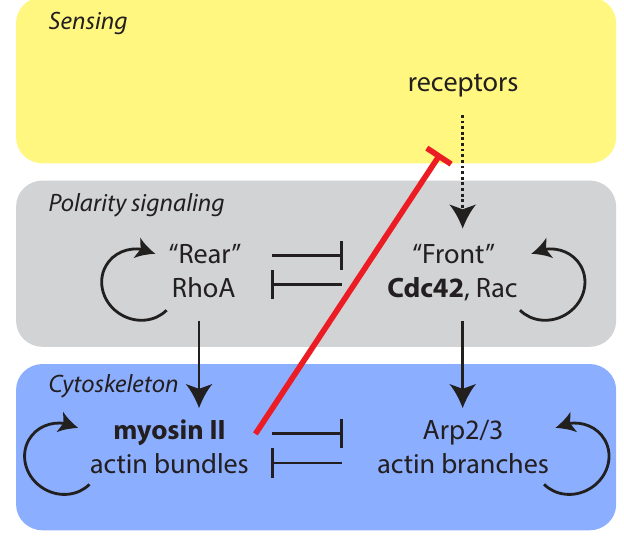
Fig. 8 Simpli fi ed model of cell polarization. Neutrophil polarization is thought to arise through antagonism between front and rear signaling modules. Information is typically thought to fl ow from a sensing module containing receptors (yellow layer) to the polarity signaling circuit